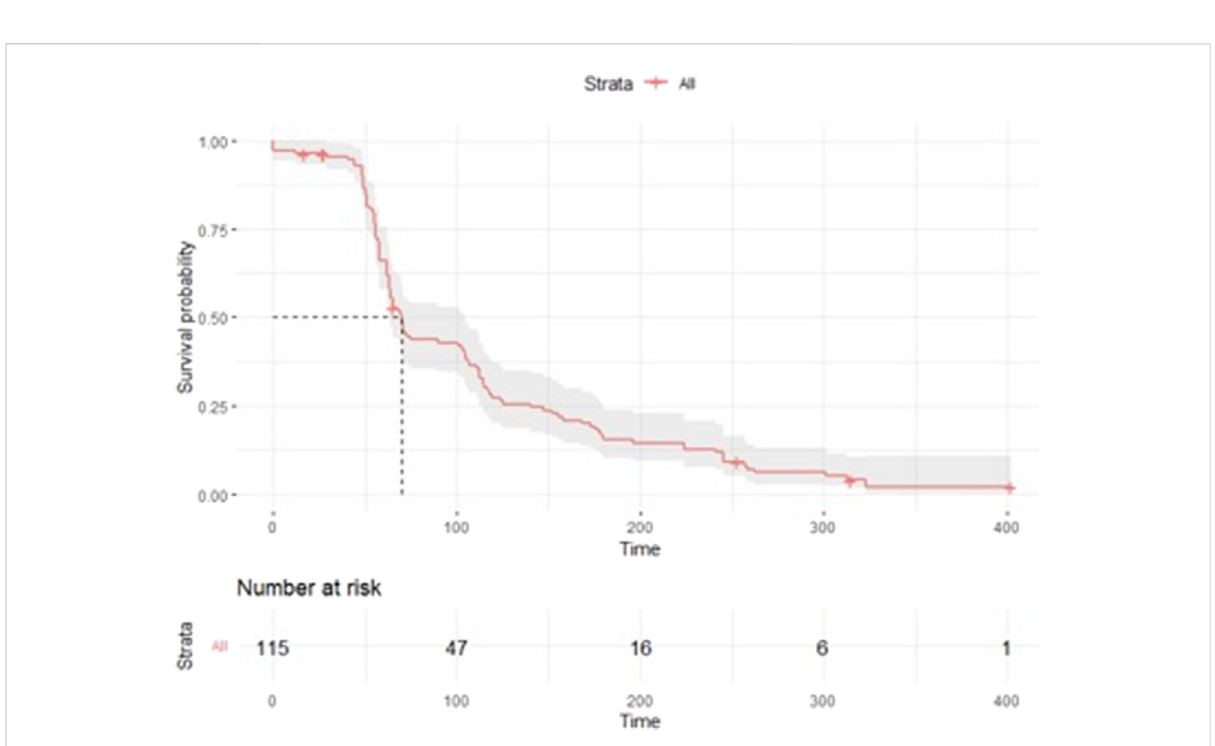
FIGURE 3 Time to experience a new medicine-related problem or